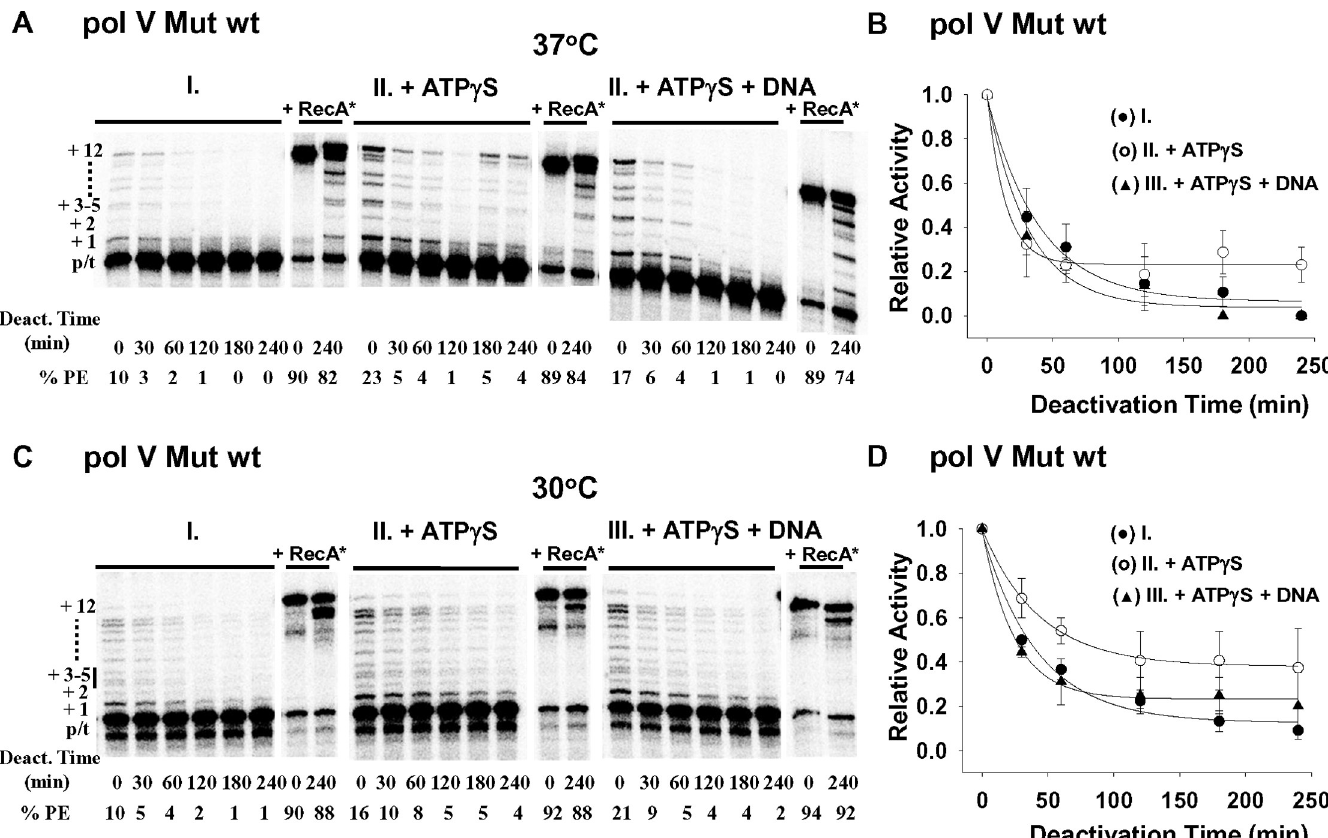
Fig 5. Static deactivation of pol V Mut wt at 37˚C and 30˚C. Static deactivation of pol V Mut wt was measured as shown in Fig 4A. Pol V Mut wt deactivates statically in the absence of DNA synthesis at 37˚C (A-B) and 30˚C (C-D). Pol V Mut wt was incubated either alone (I. and black circles in the graphs) or with ATP γ S (II. and white circles in the graphs), or with ATP γ S and 12nt oh HP DNA (III. and black triangles in the graphs). The static deactivation conditions and analysis are described in the legend for Fig 4. Pol V Mut wt deactivates more slowly at 30˚C (C-D) compared to 37˚C (A-B). However, in contrast to pol V Mut E38K/ Δ C17 (Fig 4), the degree of stabilization with ATP γ S is much less for pol V Mut wt. Deactivated pol V Mut wt is reactivated by incubation with RecA � (+RecA �